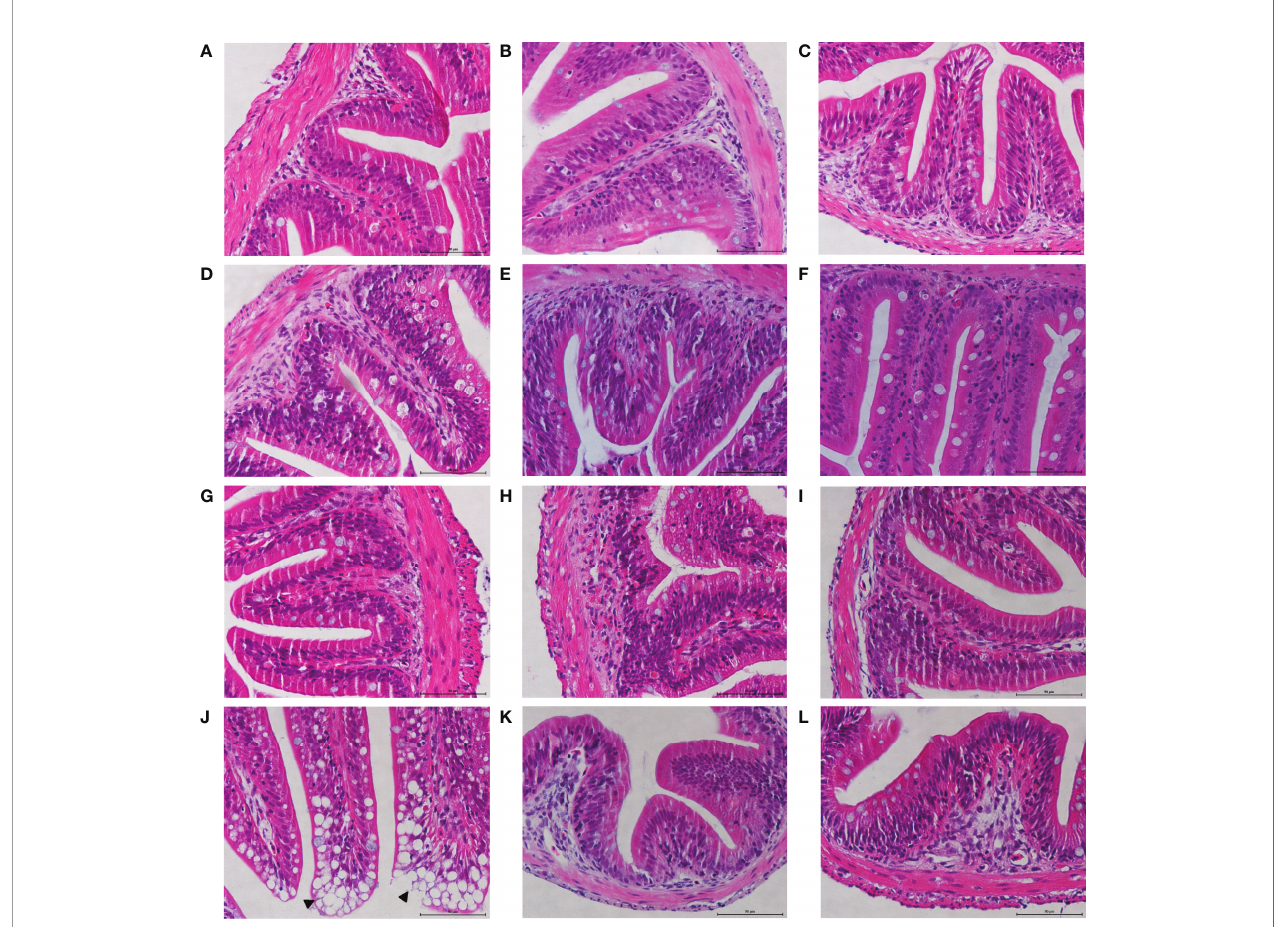
FIGURE 3 | Effects of MOS supplementation on the intestinal histological structures of juvenile M. amblycephala by H&E staining. (A – C) Mid-intestine sections of control, MOS200, and MOS400 groups at 0 hpi, respectively. (D – F) Sections at 12 hpi. (G – I) Sections at 24 hpi. (J – L) Sections at 72 hpi. The pathological symptoms were marked with triangle. Scale bars represented 50 µm